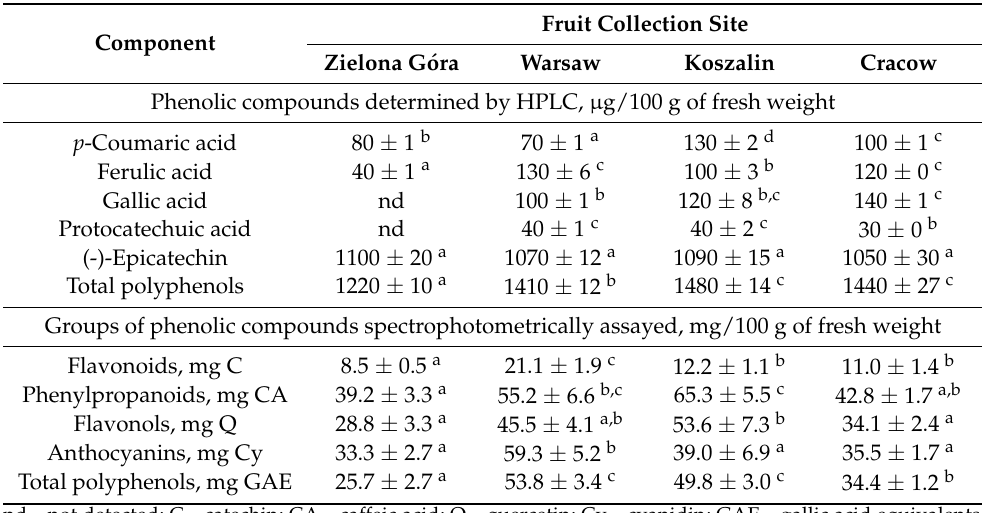
Fruit Collection